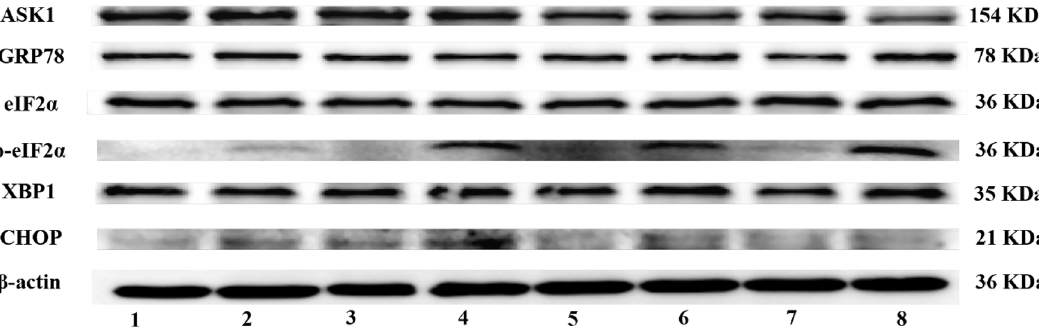
Figure 16. The protein expression alterations of endoplasmic reticulum stress signal pathway-related regulatory molecules in different treatments. After being treated for 24 h, the expression of ASK1, GRP78, XBP-1, eIF2α, p-eIF2α and CHOP were determined using the western blot. β-actin served as an internal marker. The different treatments were: 1. Control treatment (T1); 2. SBA treatment (T9); 3. KRT8-siRNA treatment (T2); 4. KRT8-